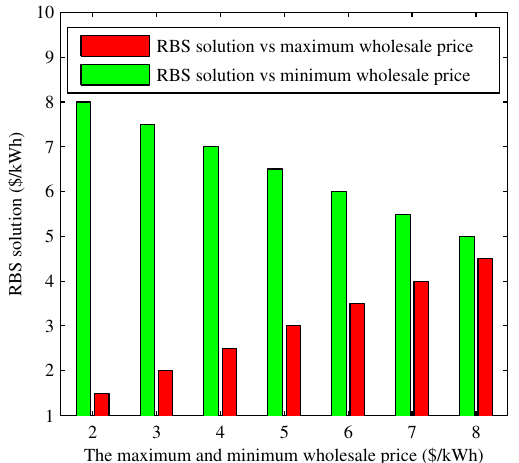
Figure 5. The Raiffa–Kalai–Smorodinsky bargaining solution (RBS) versus maximum wholesale price and minimum wholesale price.